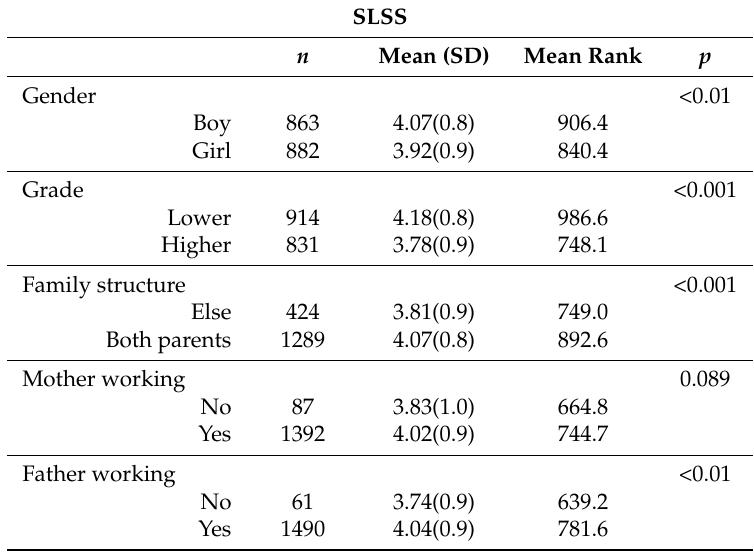
Table 1. Socio-economic background variables affecting children’s life satisfaction analysed by t -test for independent